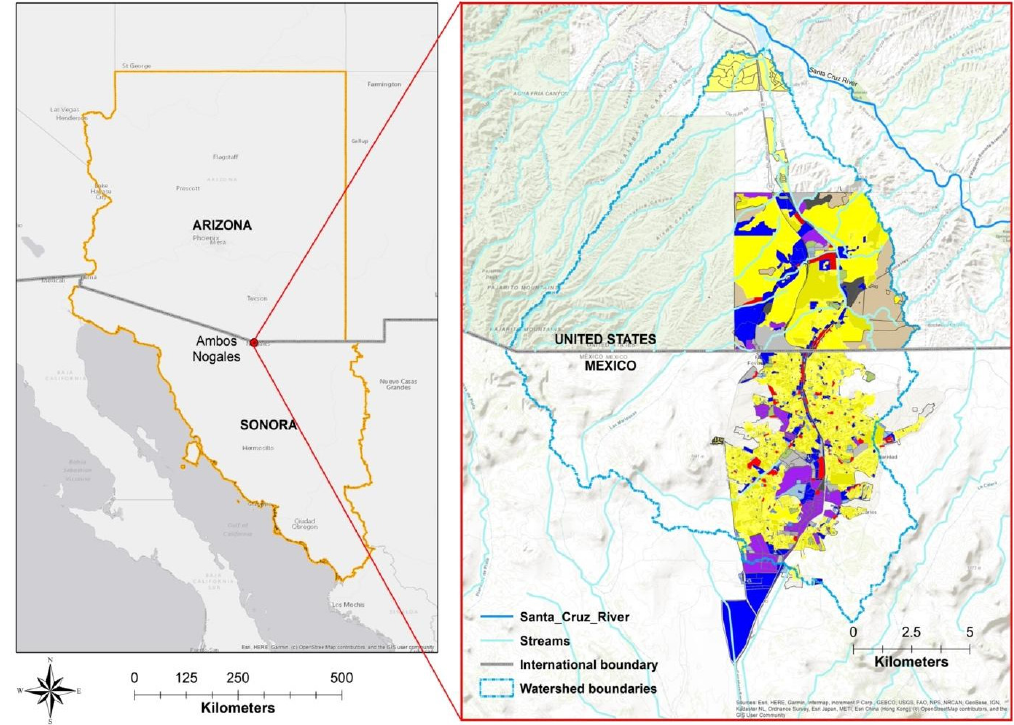
Figure 2. Map of Ambos Nogales and their relationship to the Santa Cruz River (credit: Lara-Valen- cia).